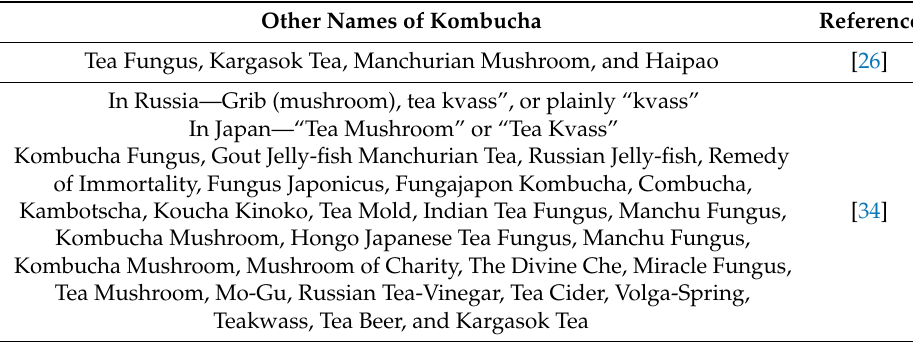
Table 2. Other names of kombucha in